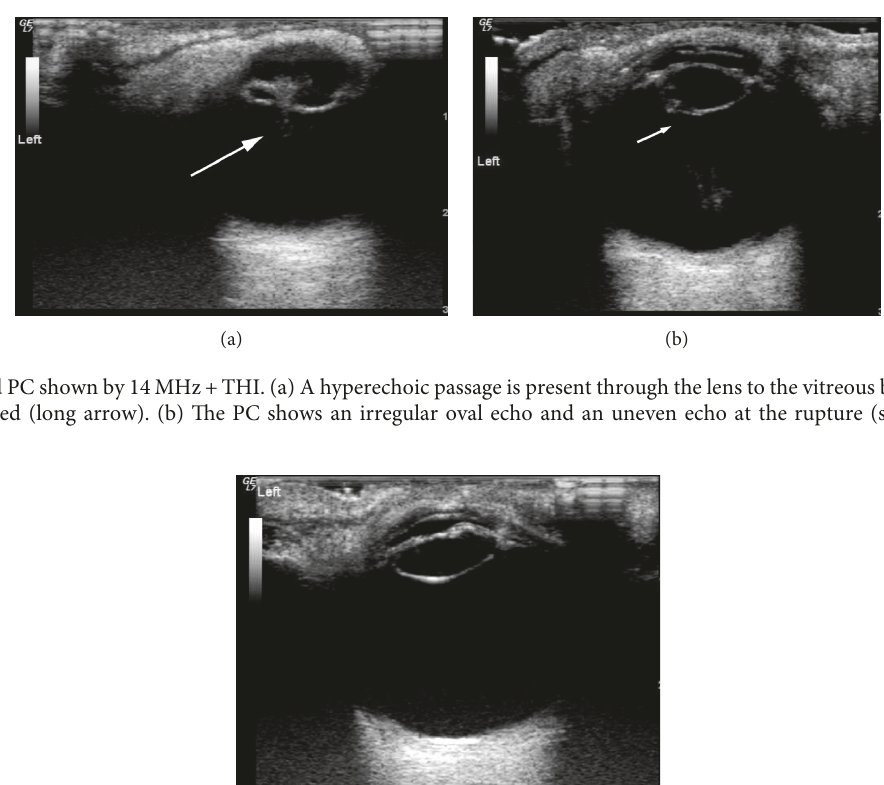
Figure 2: Intact PC shown by 14MHz +THI. The shape of the lens is regular, the internal echo is uniform, the anterior capsule is ruptured, and the PC echoes are smooth and continuous.